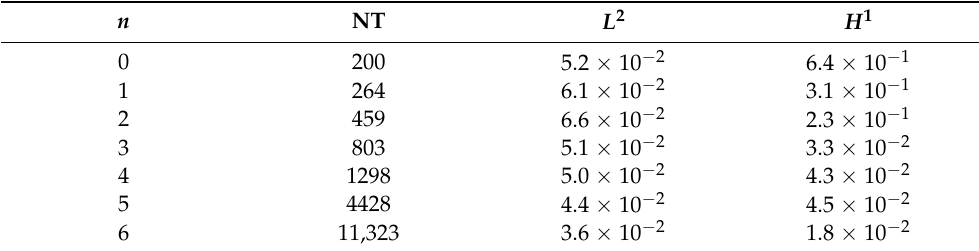
Table 12. Error in L 2 norm and H 1 seminorm for example 4 obtained with η N